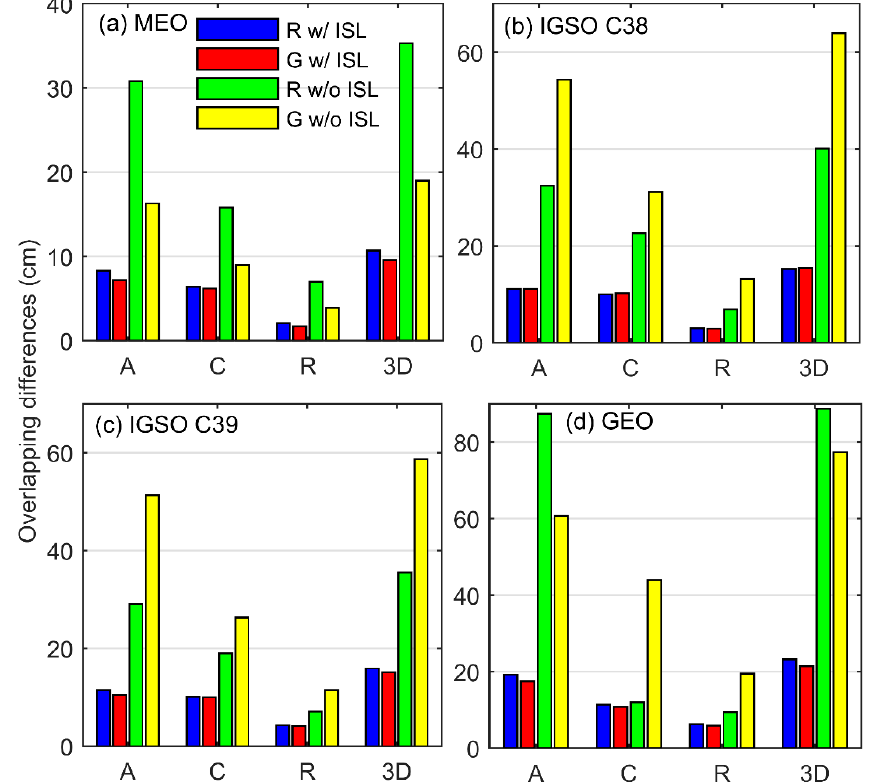
Figure 9. BDS-3 orbit accuracy obtained by regional (R) or global stations (G) with or without ISL measurements for: MEO satellites ( a ); IGSO satellite C38 ( b ); IGSO satellite C39 ( c ); and GEO satellite C59 ( d ).